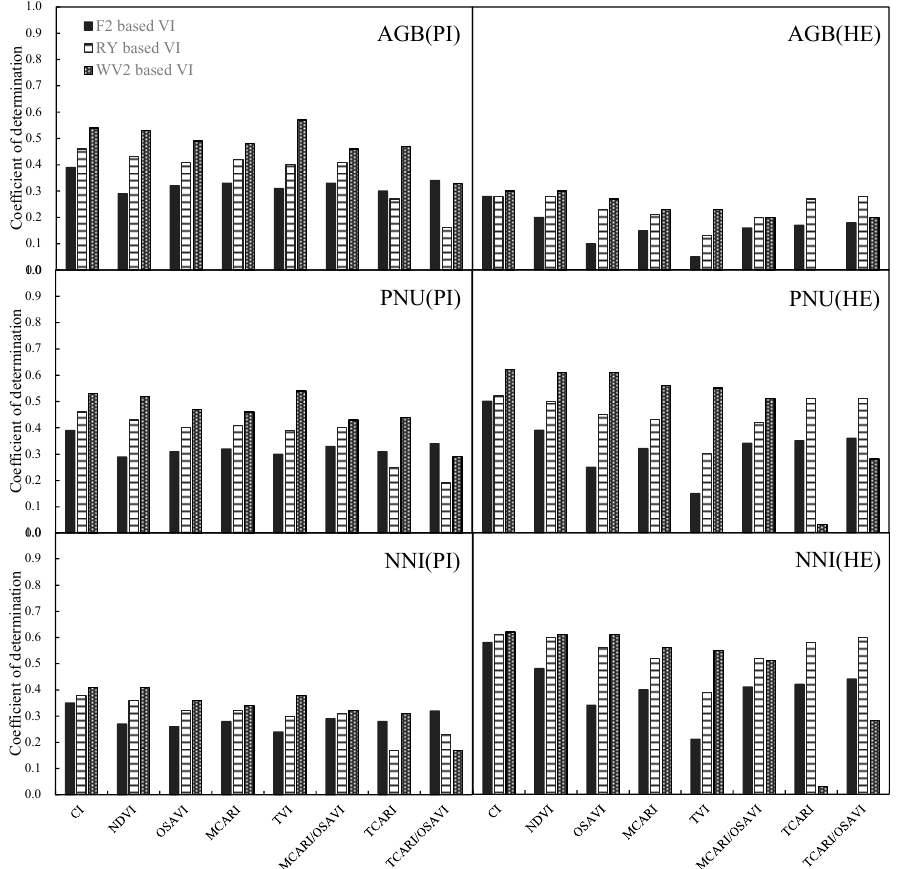
Figure 3. Comparison of different vegetation indices (VIs) calculated using FORMOSAT-2 (F2), RapidEye (RY) and WorldView-2 (WV2) satellite data for the relationships with aboveground biomass (AGB), plant N uptake (PNU), and N nutrition index (NNI) at the panicle initiation (PI) and heading (HE) stages, respectively.